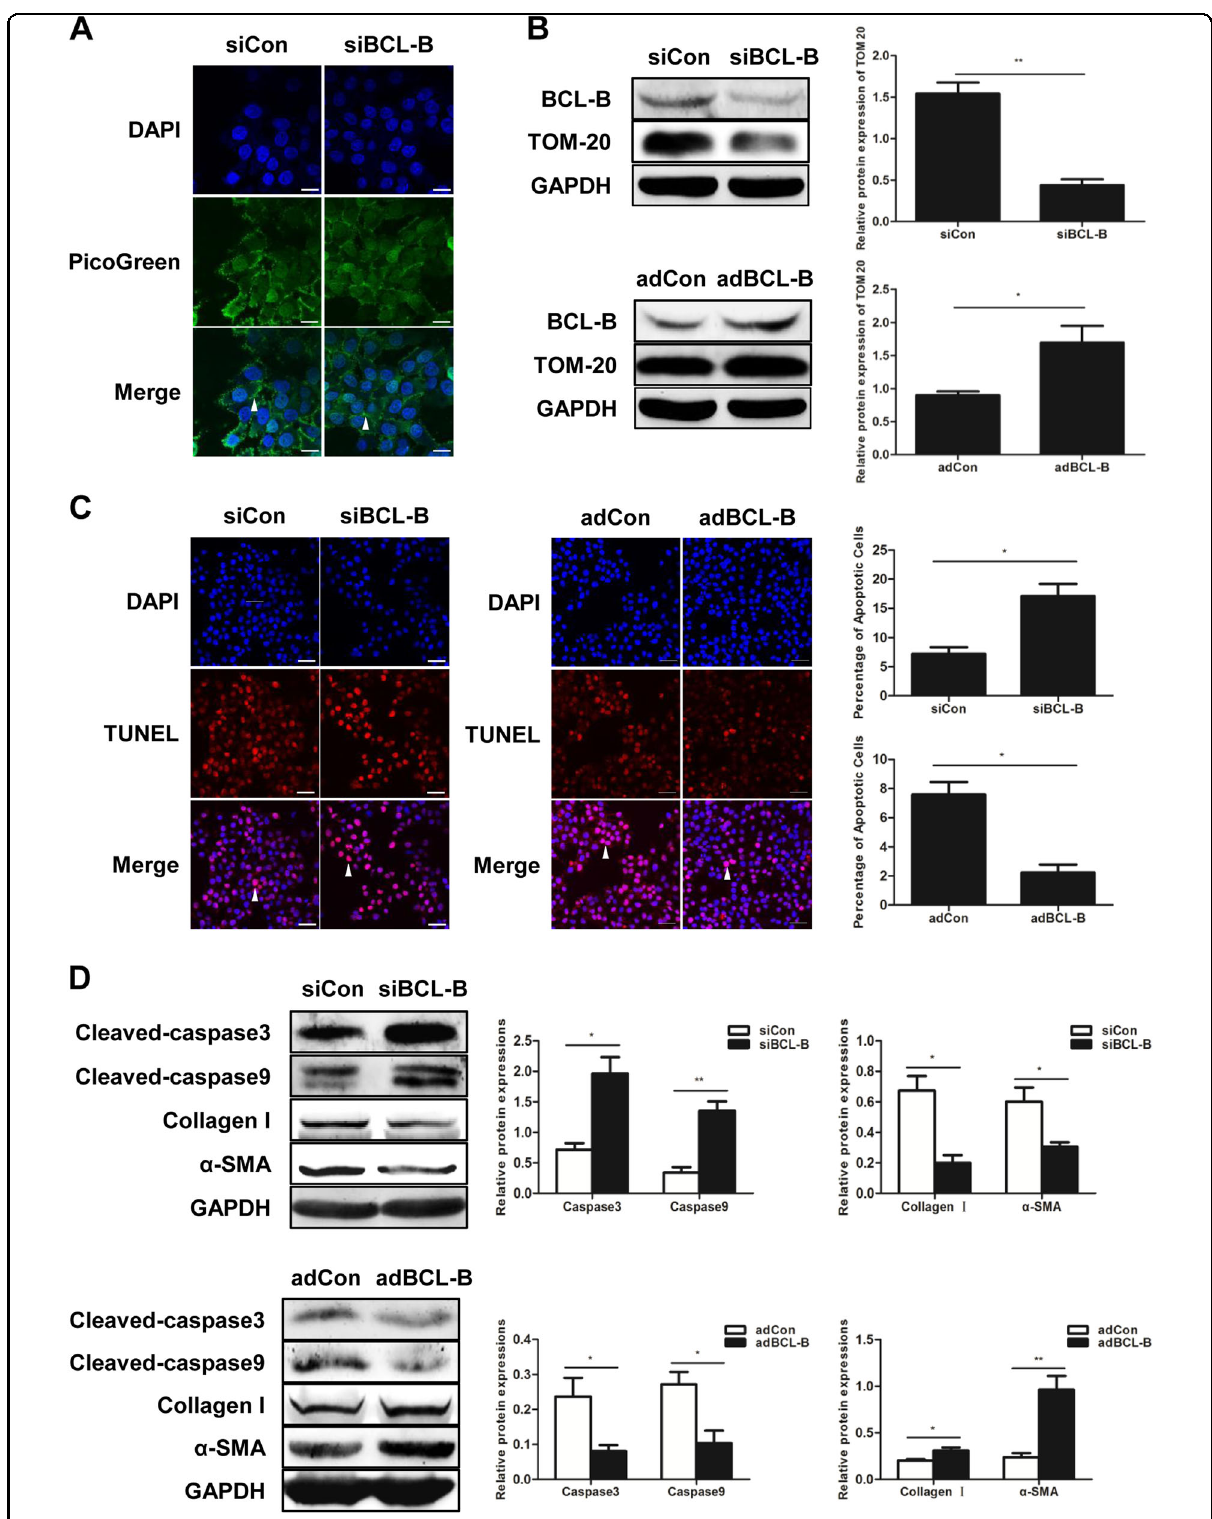
Fig. 5 (See legend on next